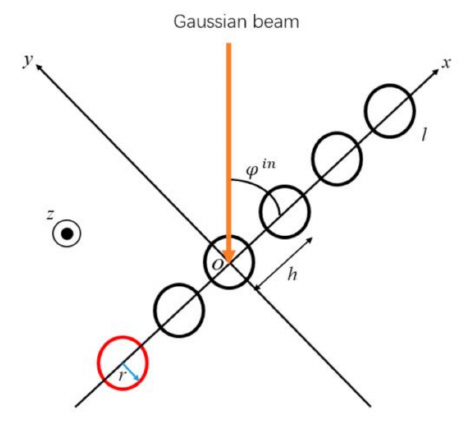
Figure 8. Schematic diagram of the periodic cylindrical wire array